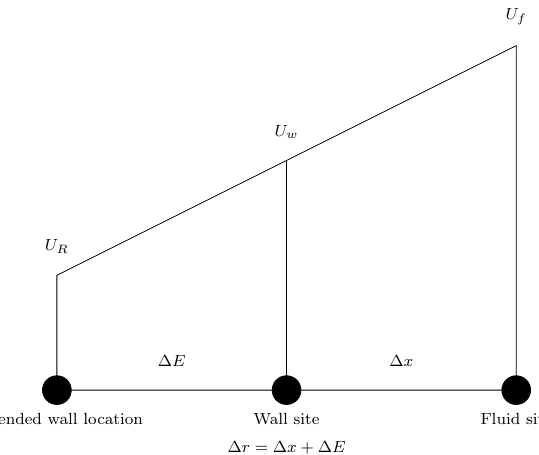
Figure 1. Schematic layout of fluid node, wall node and hypothetical wall location for the proposed boundary scheme. The extended wall location represents the position of the edge of the wall when it extends beyond the physically simulated domain.